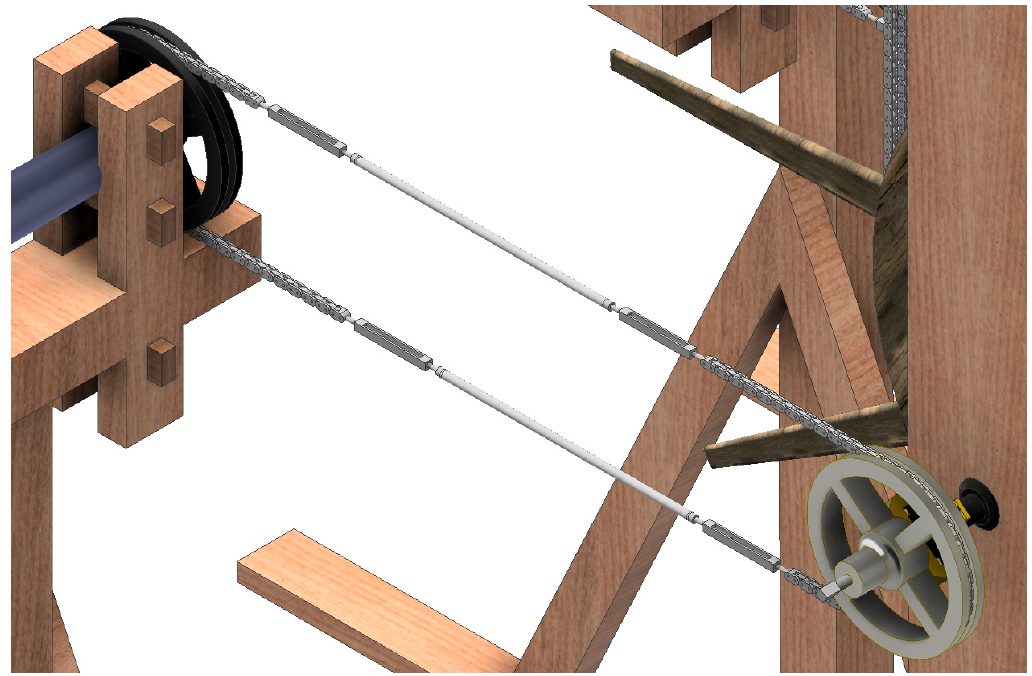
Figure 18. Detail of the transmission between metal pulleys.